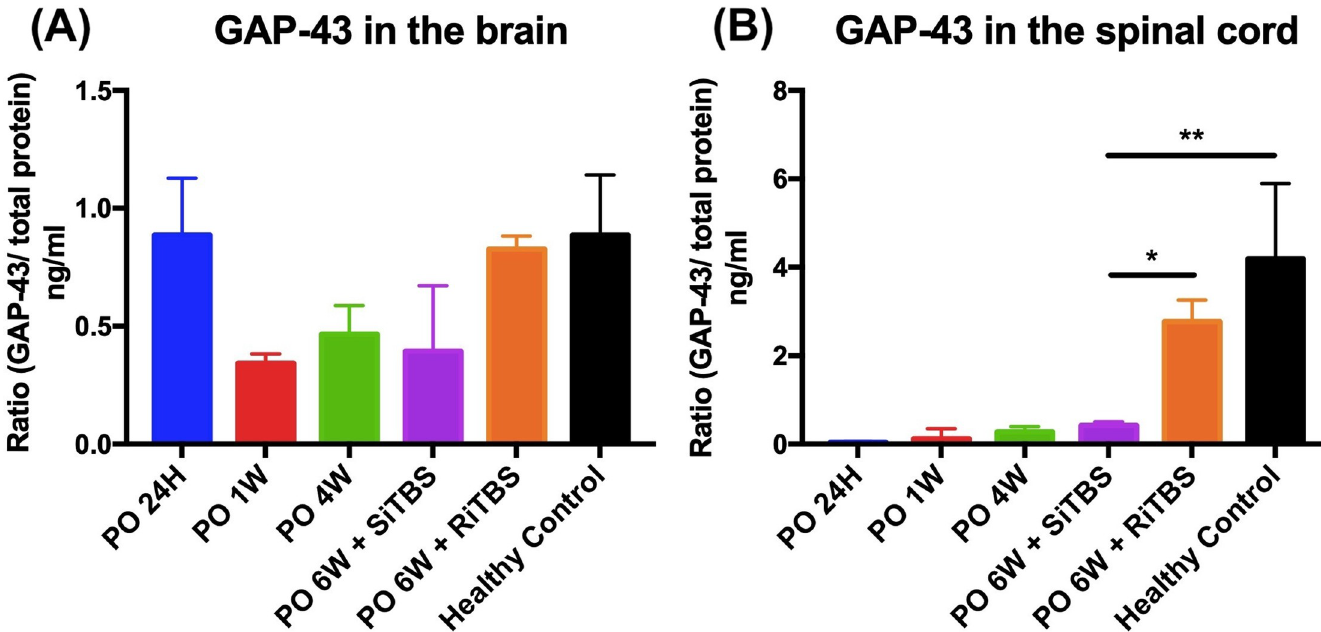
Fig 6. Time course of average changes in expressions of growth-associated protein (GAP)-43. GAP-43 levels in the brain (A and spinal cord (B) at different time points. Each different time point in both the brain and spinal cord corresponded to the ratio of GAP-43/total protein. � p < 0.05, �� p < 0.01, by post-hoc LSD multiple- comparison tests on GAP-43 expression from each time point compared to the severe-spinal cord injury (SCI) + sham intermittent theta-burst stimulation (SiTBS) group.